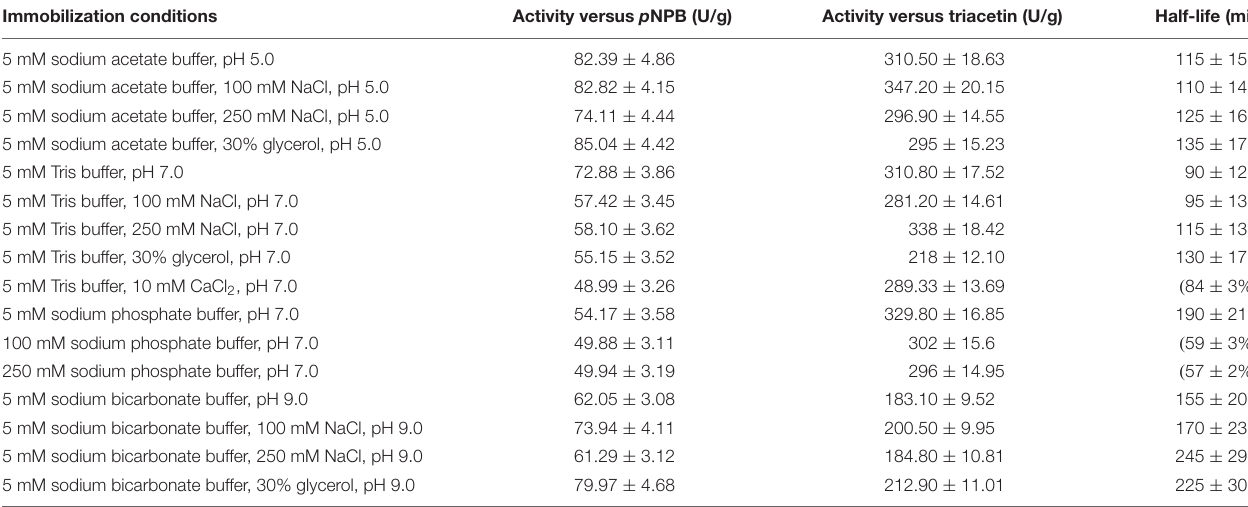
TABLE 3 | Activities versus different substrates and half-lives of different PFL biocatalysts prepared under different immobilization conditions. Immobilization